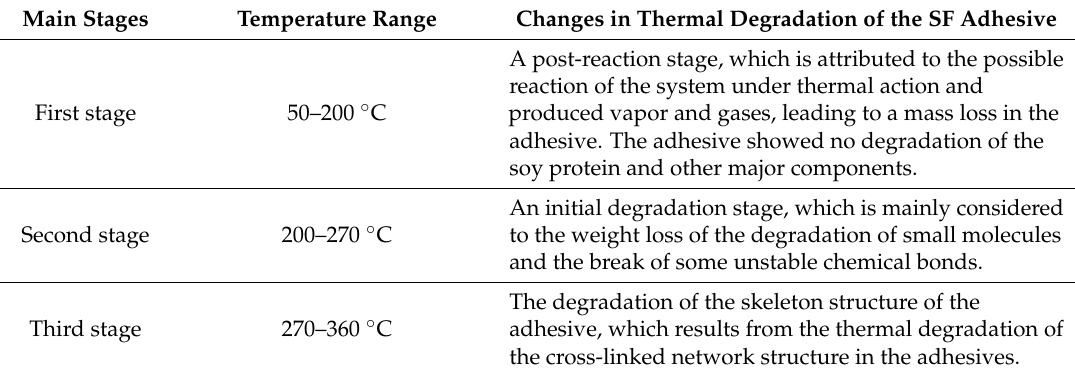
Table 3. Three main stages in thermal degradation of the SF